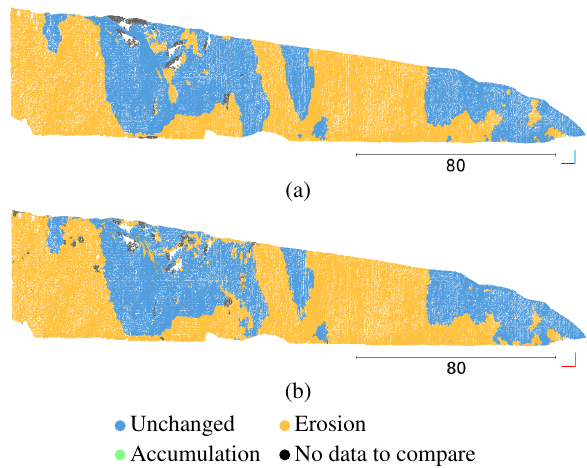
Figure 5. Results on east part of the cliffs between 2018 and 2020 acquisition. Points of the ground truth (a) and in Siamese KPConv results (b) are colorized according to the change.